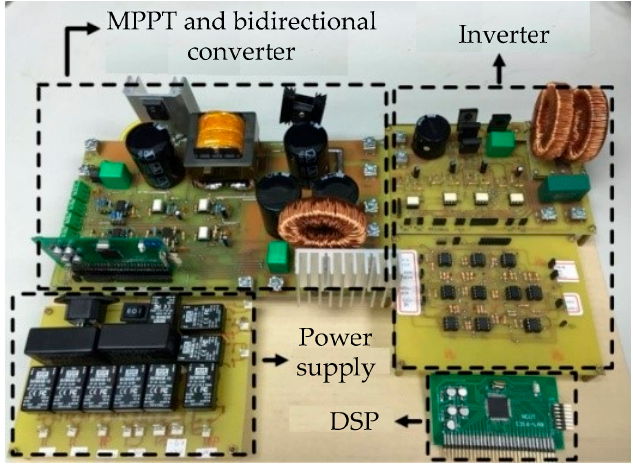
Figure 6. Photo of proposed circuit.